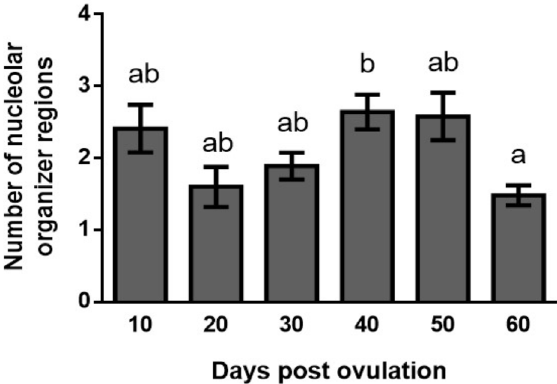
Figure 4 - Mean and standard error of the ratio between the total areas of the cell nuclei and the total areas of the nucleolus organizer regions (NORs), higher ratios are indicative of greater cell proliferation of the endometrium of the horns of the bitches at 10 (n=10), 20 (n=7), 30 (n=8), 40 (n=8), 50 (n=6) and 60 (n=9) days post ovulation. Different letters indicate statistically significant differences (p